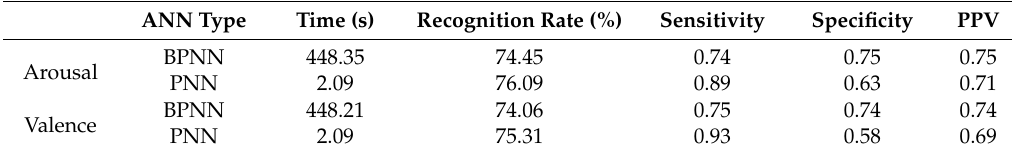
Table 6. Comparison of results from BPNN and PNN.